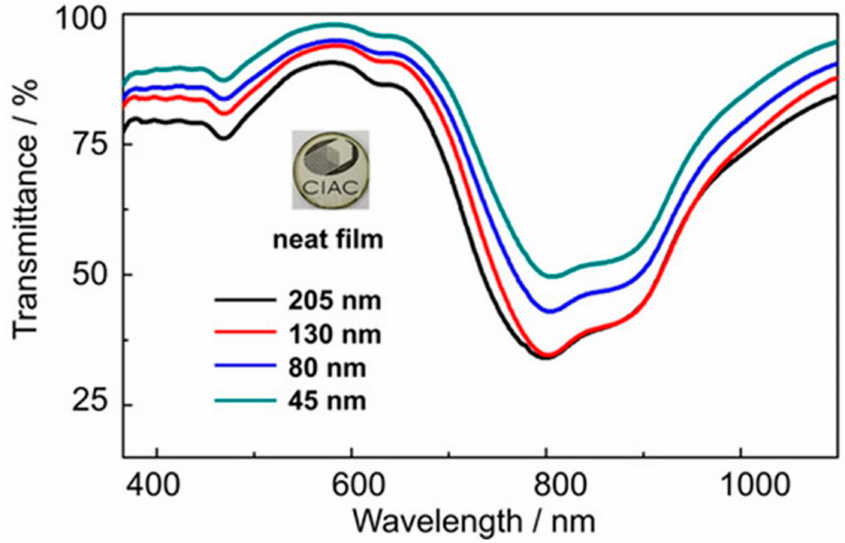
Figure 7. Transmittance of compound 159 as thin films of different thickness. (Reproduced with permission from Yang Min, Chemistry—A European Journal; published by Chemistry Europe,